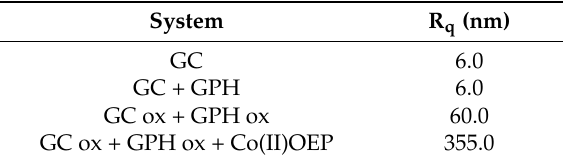
Table 1. R q values for the GC systems and modified GC